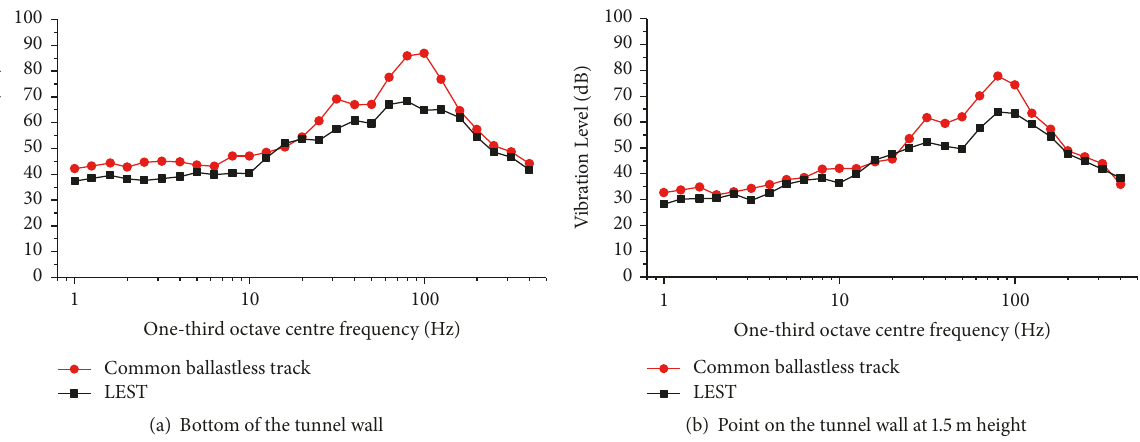
Figure 16: One-third octave curves of the tunnel wall vibration levels in curved track.